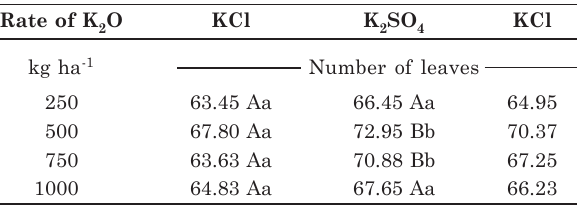
Equal capital letters in the column and the same lowercase letters in a row do not differ from each other at the 5 % by the Scott-Knott test. Table 3. Effect of K rates and sources on plant height at 30, 60, 90 and 110 days after transplanting (DAT)